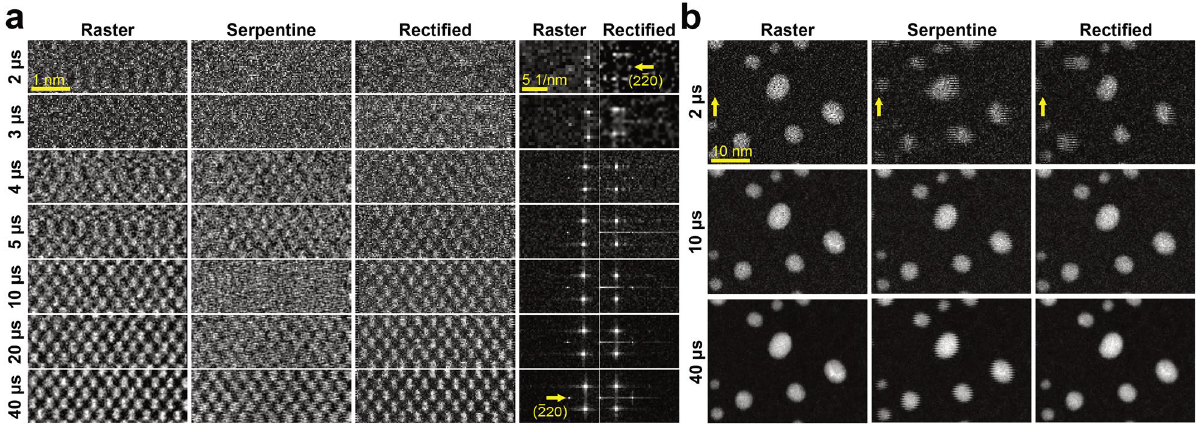
Figure 4. Comparison between rectified and experimental STEM images. ( a ) Atomic resolution images of [110] Si at different T D . The raster and serpentine scans are acquired with τ = 400 and 10 μs, respectively. The Fourier transform of the raster and rectified images highlight the presence of the (220) diffraction spot at 0.192 nm. ( b ) Rectification of STEM images from gold nanoparticles AuNPs using the scan distortions parameterized from ( a